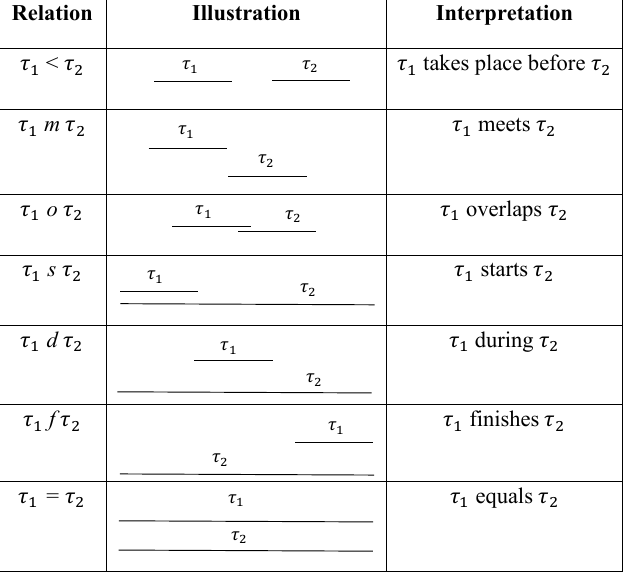
Figure 3. Possible relations between two time